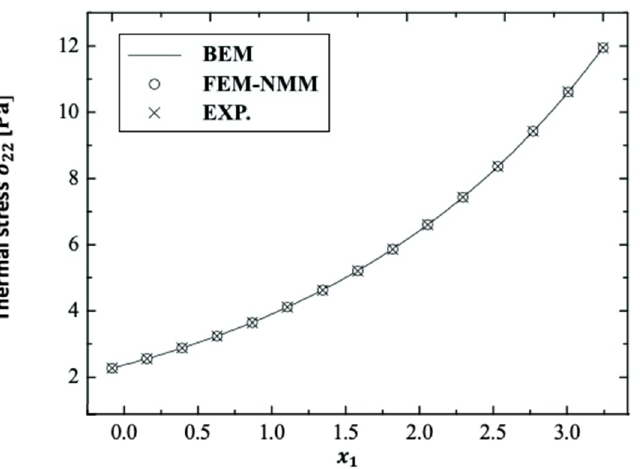
Figure 16. Distribution of the thermal stress wave 𝜎 (cid:2870)(cid:2870) along 𝑥 (cid:2869) – axis in the special case of aniso- tropic FRP composites for BEM, FEM-NMM, and Exp. FRP composites for BEM, FEM-NMM, and